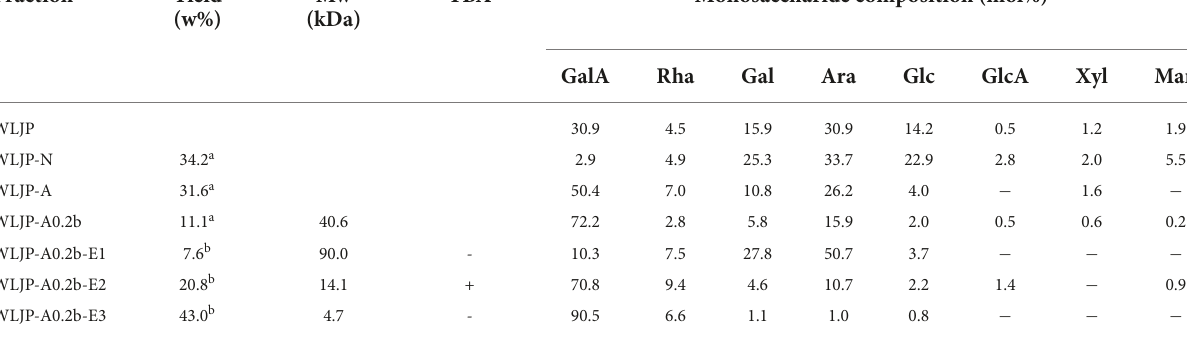
TABLE 1 Yields, Mws, and monosaccharide compositions of polysaccharide fractions from Lonicerae japonicae Thunb. Fraction Yield (w%)